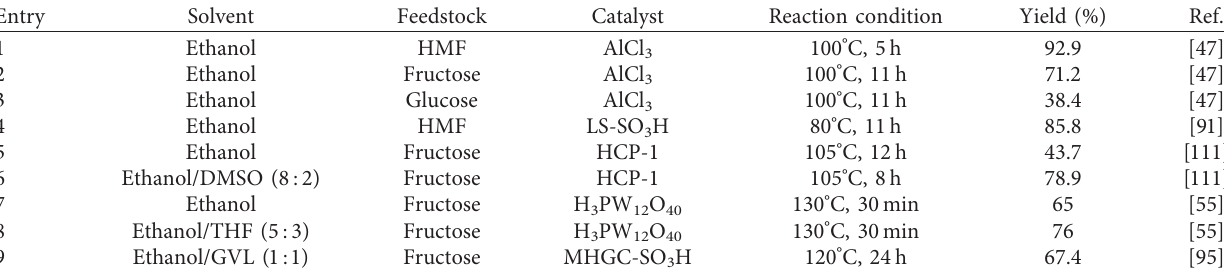
Table 5: Various solvents used for EMF